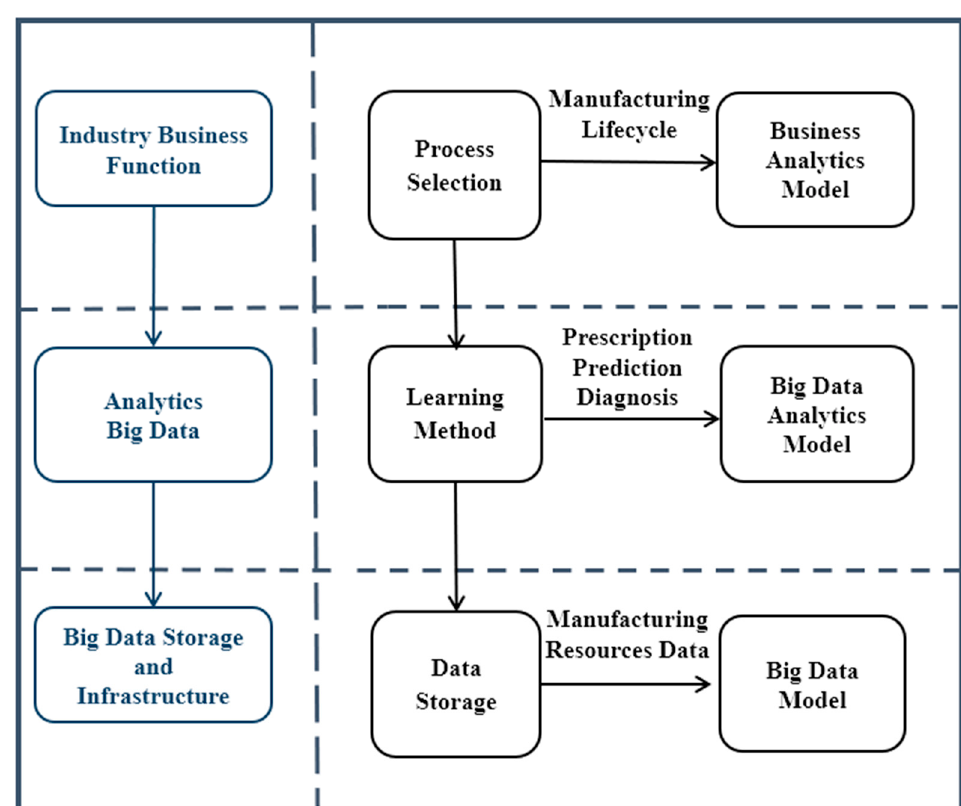
Figure 2. Big Data analytics management model.